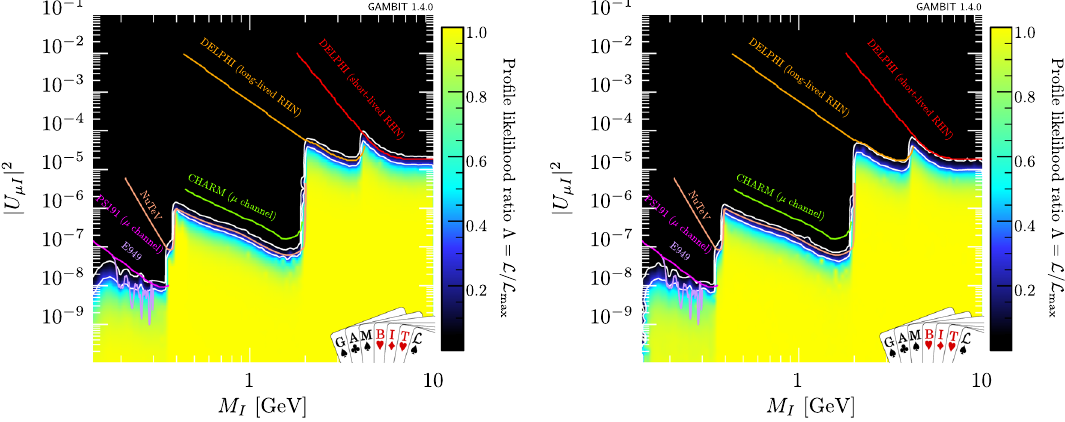
Fig. 9 Profile likelihood in M I vs U 2 μ plane with M I < 10 GeV and overlaid direct detection limits, for normal (left) and inverted hierarchy (right) I